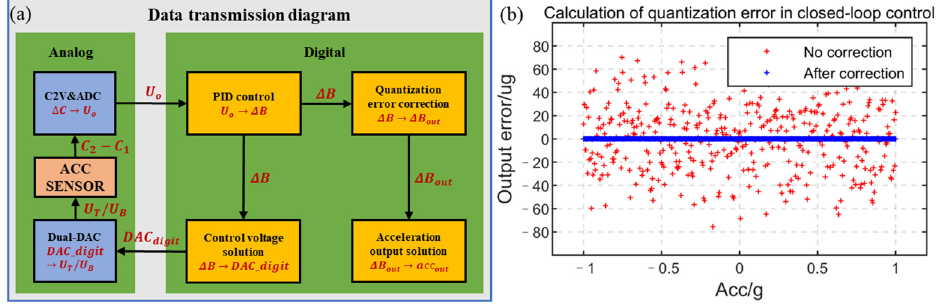
Figure 8. Quantization error: ( a ) data transmission diagram and ( b ) calculation of the quantization error in closed-loop control. error in closed-loop